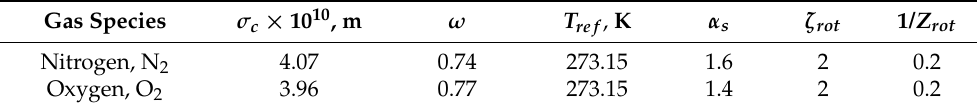
Table 1. Parameters for the variable soft sphere collision model and the Larsen-Borgnakke model used in the current study. σ c is the collision diameter, ω is the temperature exponent for viscosity, T ref is the reference temperature, α s is the angular scattering parameter, ζ rot is the number of rotational degrees of freedom, and Z rot is the rotational relaxation